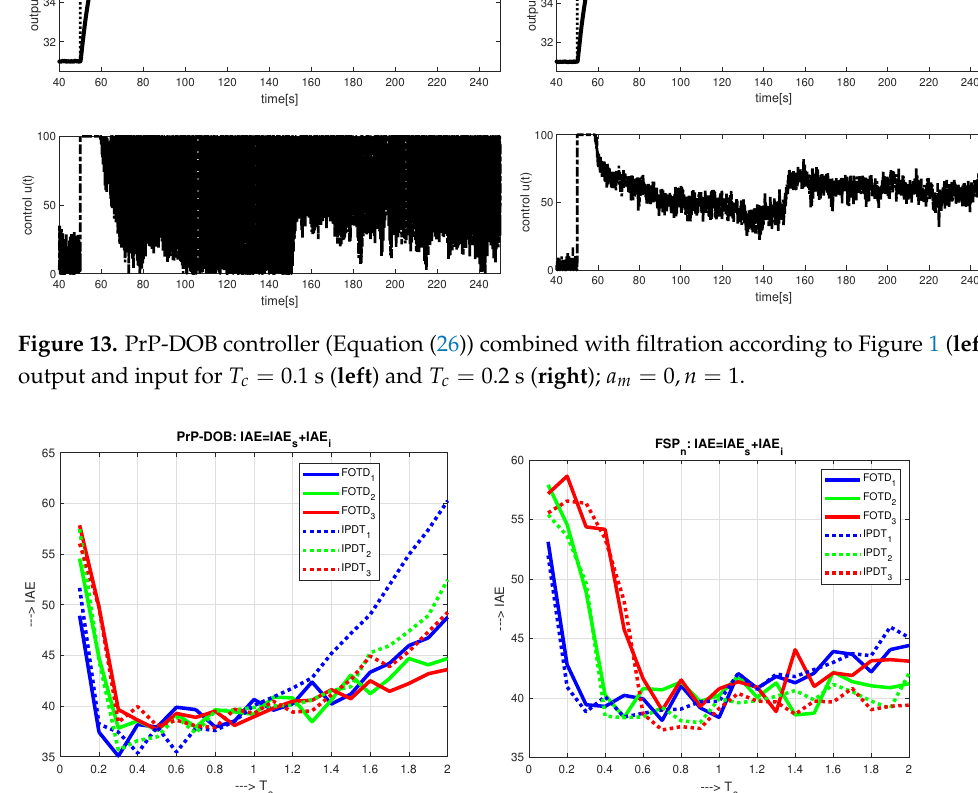
Figure 14. PrP-DOB controller (Equation (26)) combined with filtration according to Figures 1 and 5, λ = − n / T c ( left ) and FSP controller (Equations (39)–(52)). ( right ): Combined IAE versus the tuning parameter T c ∈ [ 0.1,2 ]